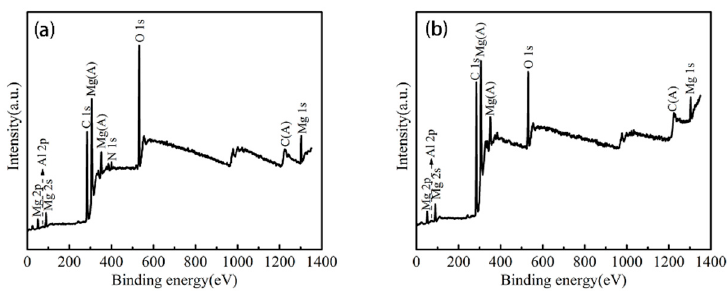
Figure 6. XPS survey spectrum of ( a ) magnesium alloy (MA), ( b ) superhydrophobic magnesium alloy (SMA).